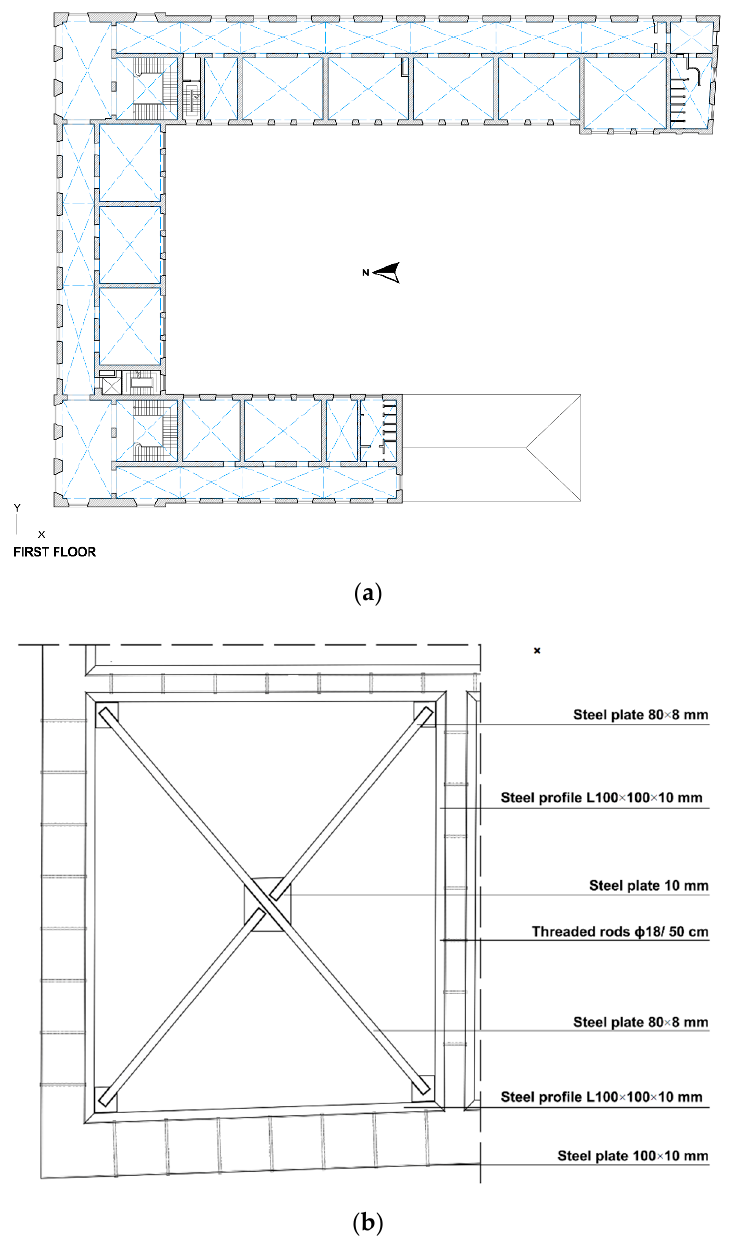
Figure 14. Layout of the proposed steel bracing system ( a ) and example of the structural scheme ( b ).